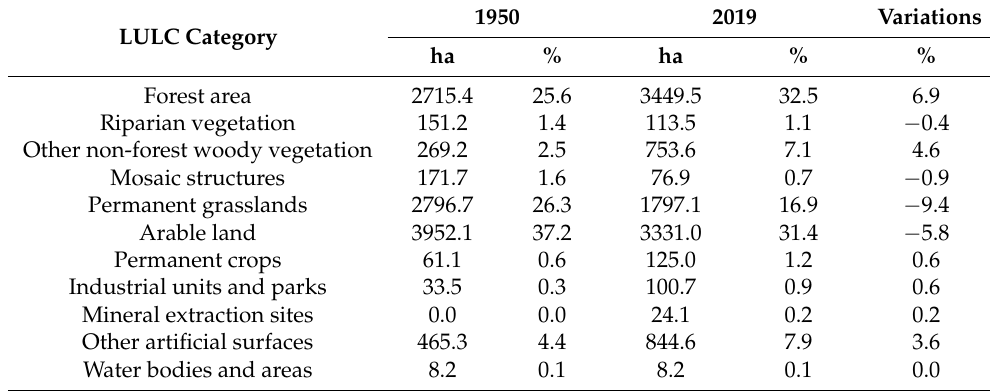
Table 7. LULC patterns for 1950 and 2019 of the Štiavnica River floodplain. LULC